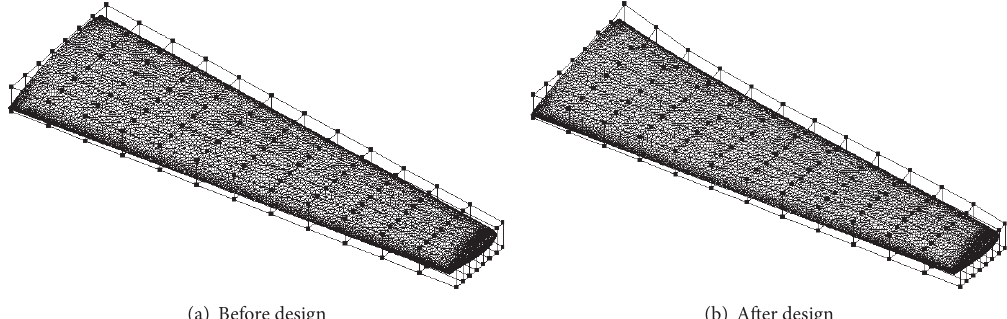
Figure 8: Surface mesh and FFD control volume of DPW-W1.